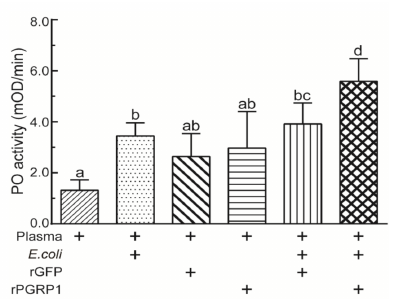
Figure 6. Stimulation of PPO activation in O. furnacalis plasma upon the addition of recombinant PGRP1. Recombinant PGRP1 (100 µ g/mL) or rGFP (as a control) were mixed with plasma from O. fur- nacali fifth-instar day 0 larvae and incubated in the presence or absence of E. coli (1.6 × 10 8 cells/mL) at room temperature for 10 min. Details of the reaction mixtures are provided in the figures. The bars represent mean ± S.D. ( n = 3). Bars labeled with different letters are significantly different (one–way ANOVA, followed by Tukey’s multiple comparisons test, p <